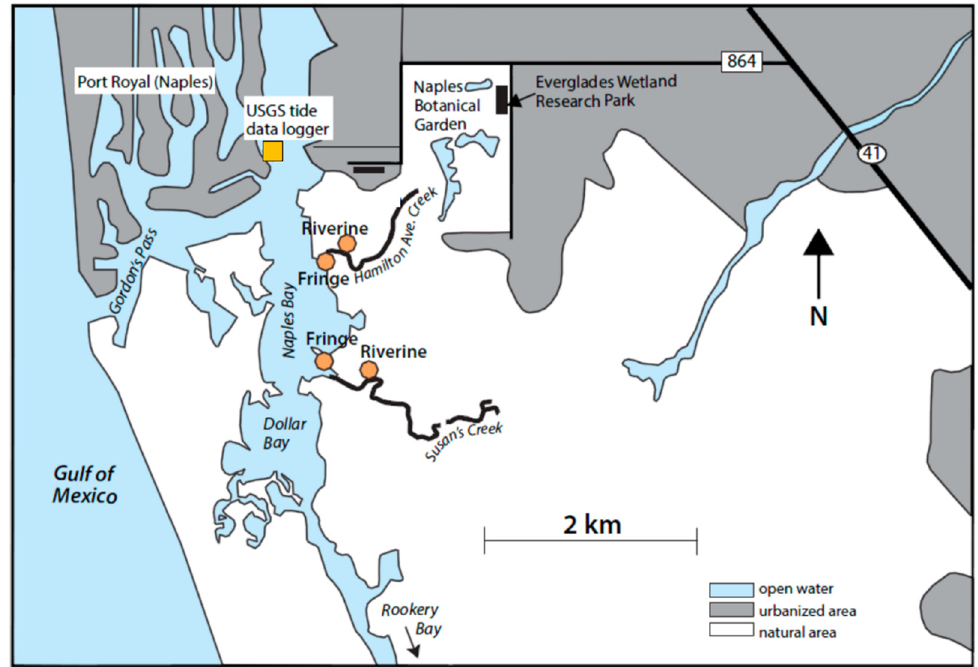
Figure 9. Sample sites on disturbed tidal creek (Hamilton Avenue Creek) and reference tidal creek (Susan’s Creek) in Naples Bay, Florida that were previously sampled by Marchio et al. [10] in the period 2013–2014 for carbon content and sequestration and were resampled in 2019 (Illustration from [10]).